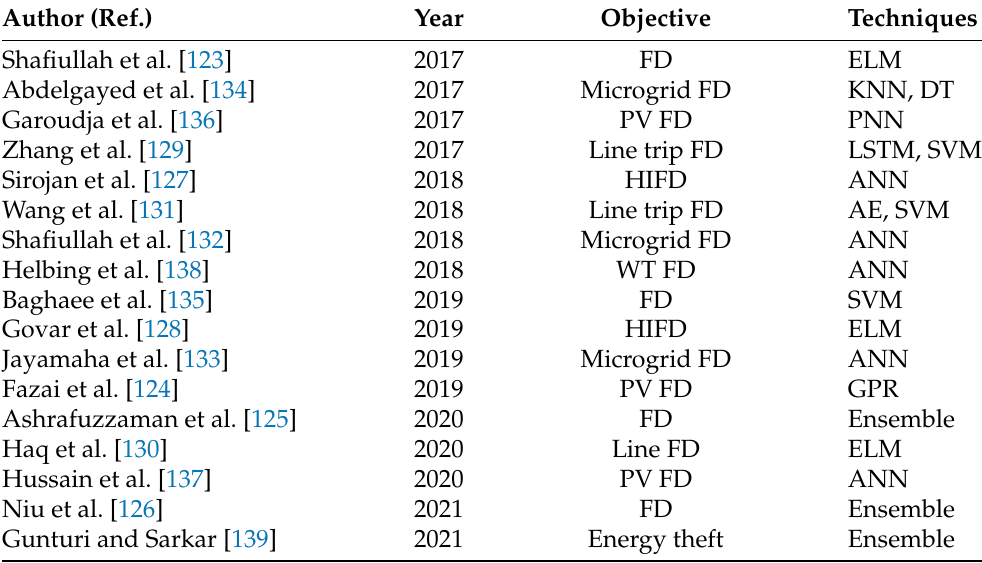
Table 3. Summary of approaches for power system